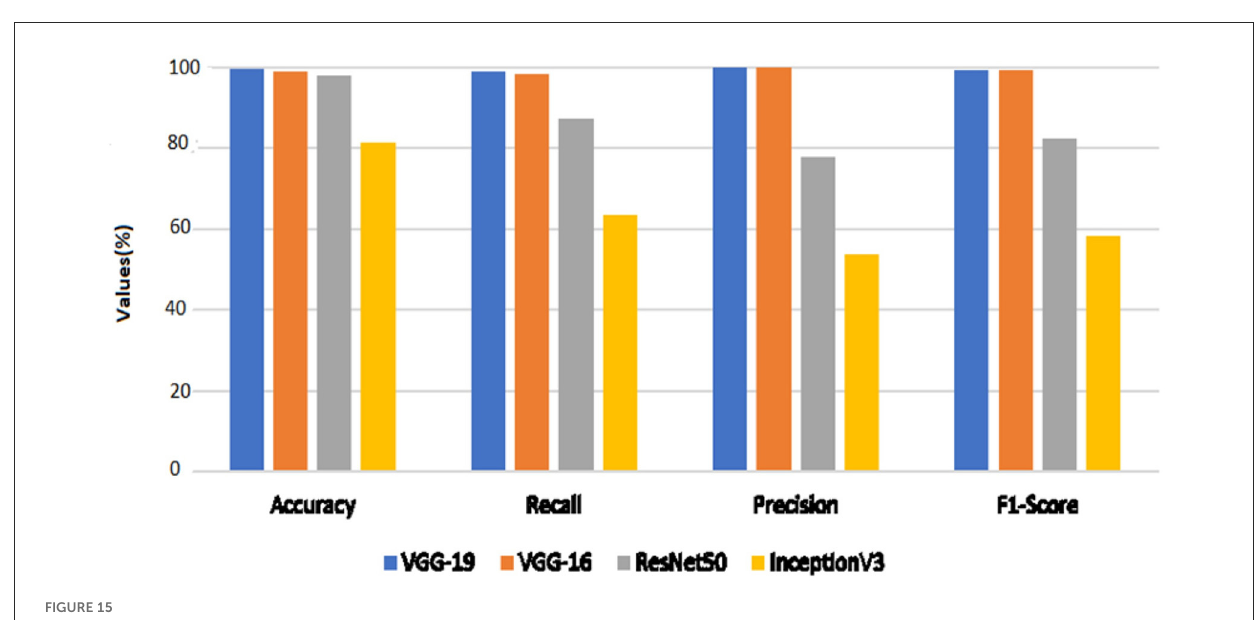
FIGURE15 Evaluation metric comparison of various classification models.